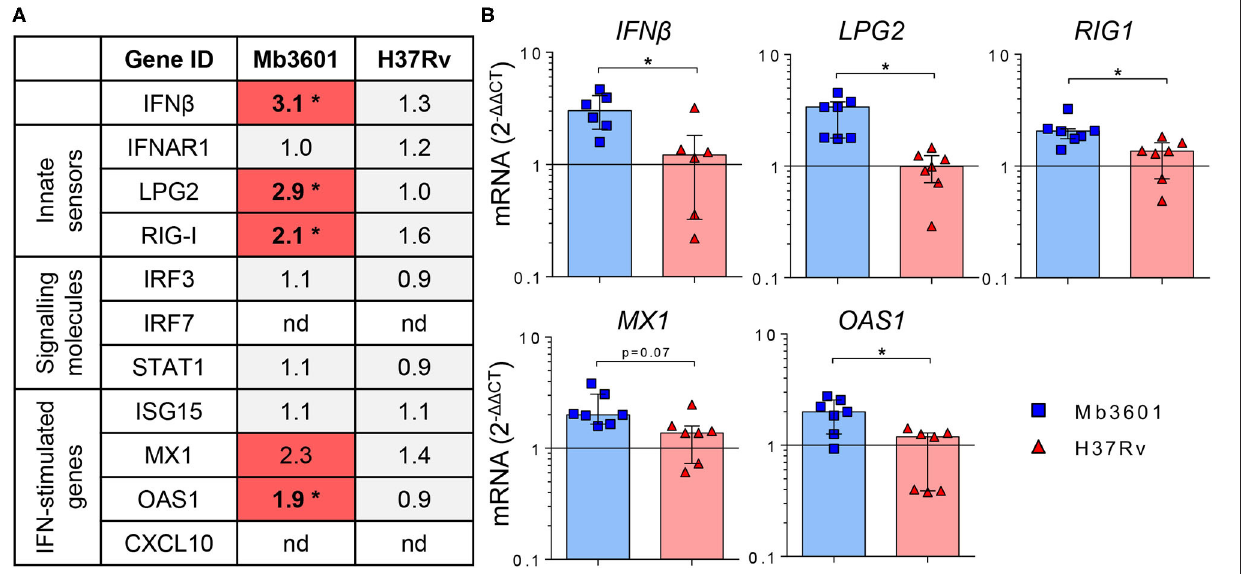
FIGURE 6 | Alveolar macrophages (AMP) from Blonde d’Aquitaine contribute to the type I IFN signature in the lung induced by Mb infection. AMPs from Blonde d’Aquitaine lungs were infected with 10 5 CFU of Mb3601 or Mtb H37Rv. At 6h later, mRNA was extracted, and the expression of major genes from the type 1 IFN pathway was analyzed. (A) Mean fold change (2 − 11 CT ) of gene expression normalized to three housekeeping genes was calculated in each group ( n = 7). The graduated red box coloring represents gene expression, and the asterisks mark significant differences compared to non-infected controls (nd, not detected). (B) IFN β , LPG2 , RIG1 , MX1 , and OAS1 gene expression in AMPs was analyzed by RT-qPCR at 6h post-infection. Individual data and the median and interquartile range in each group are presented ( n = 7). (A,B) * p < 0.05 (Wilcoxon nonparametric